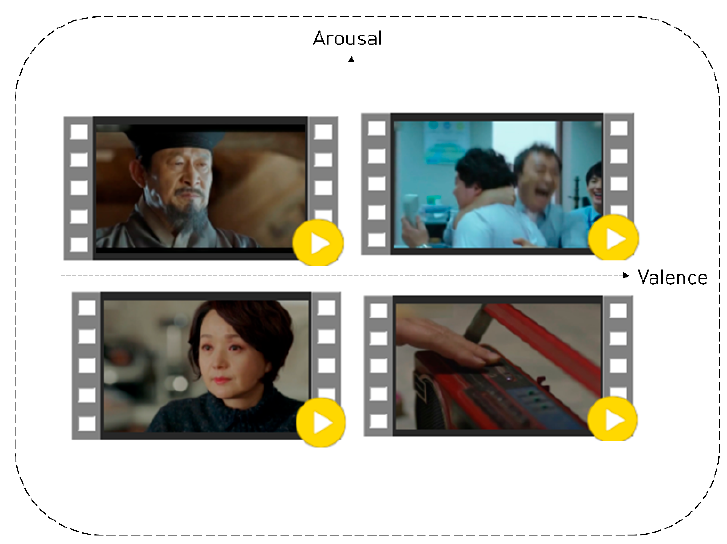
Figure 1. Video stimulus for each quadrant on a two-dimensional model.